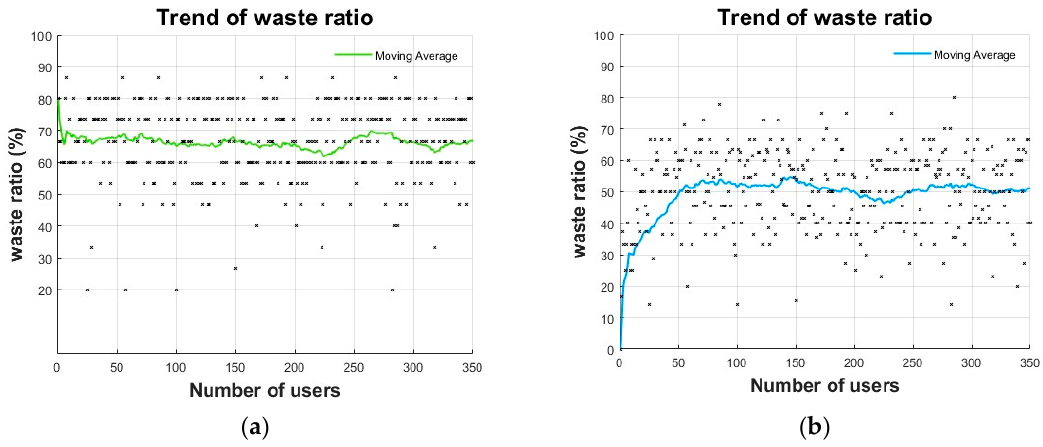
Figure 13. Result of waste ratio: ( a ) conventional methods; ( b ) proposed method.